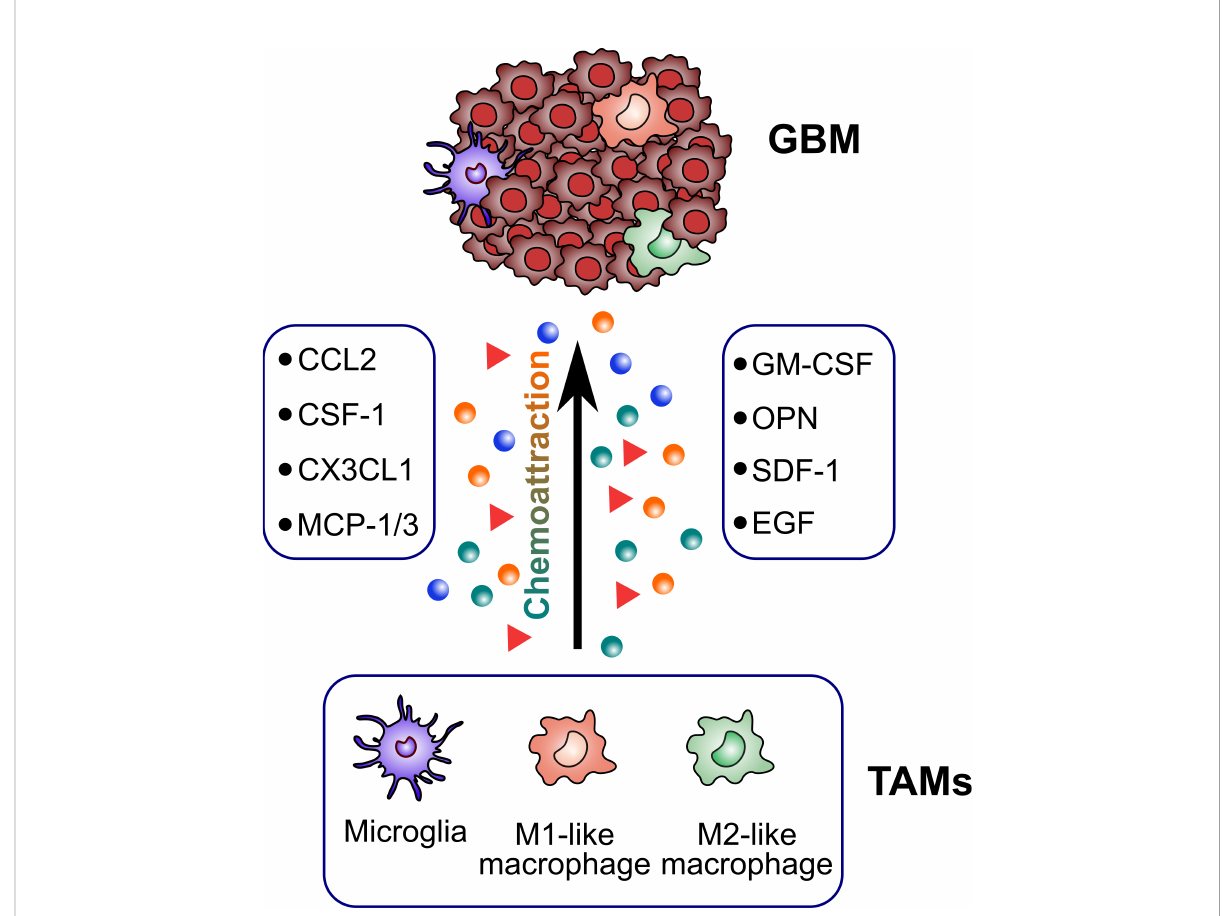
FIGURE 2 Glioblastoma-derived factors attracting TAMs. TAMs are recruited to the tumor sites by several glioblastoma-derived factors (CCL2, CSF-1, CX3CL1, MCP-1/3, GM-CSF, OPN, SDF-1,